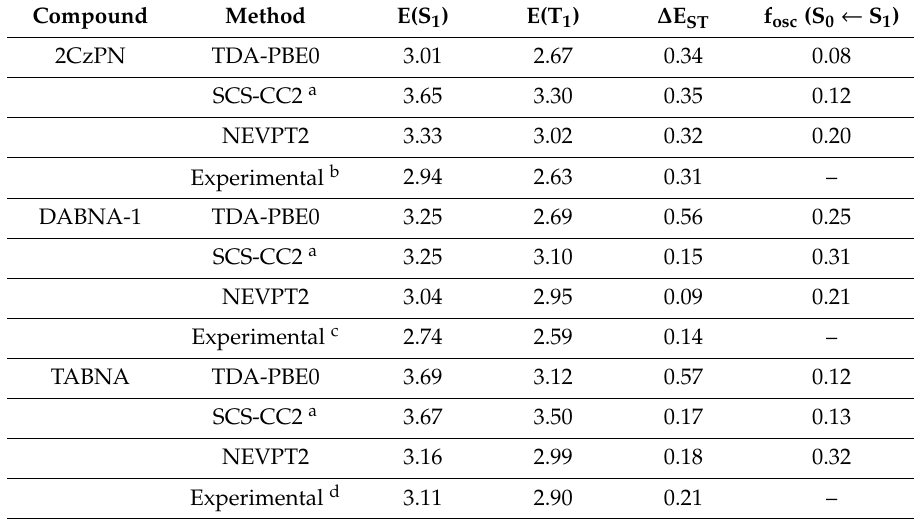
Table 1. Vertical excitation energies (in eV) of the lowest singlet and triplet states and their energy di ff erence. The oscillator strength (f osc ) values are also